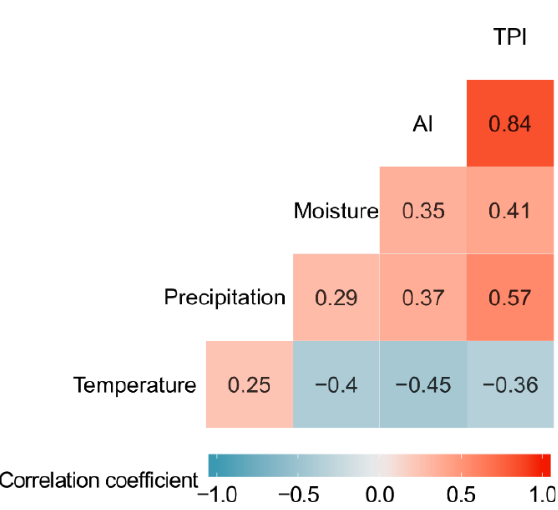
Fig. 4. Correlation coefficients between air temperature, precipitation, soil moisture at the 0–20 cm layer and AI